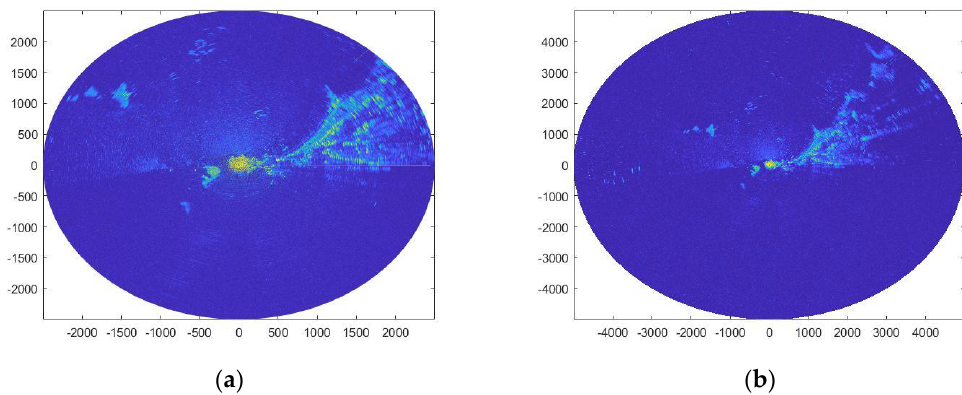
Figure 1. The measured sea clutter power. ( a ) The echo power of sea clutter within 6 km, ( b ) the echo power of sea clutter within 6 km.